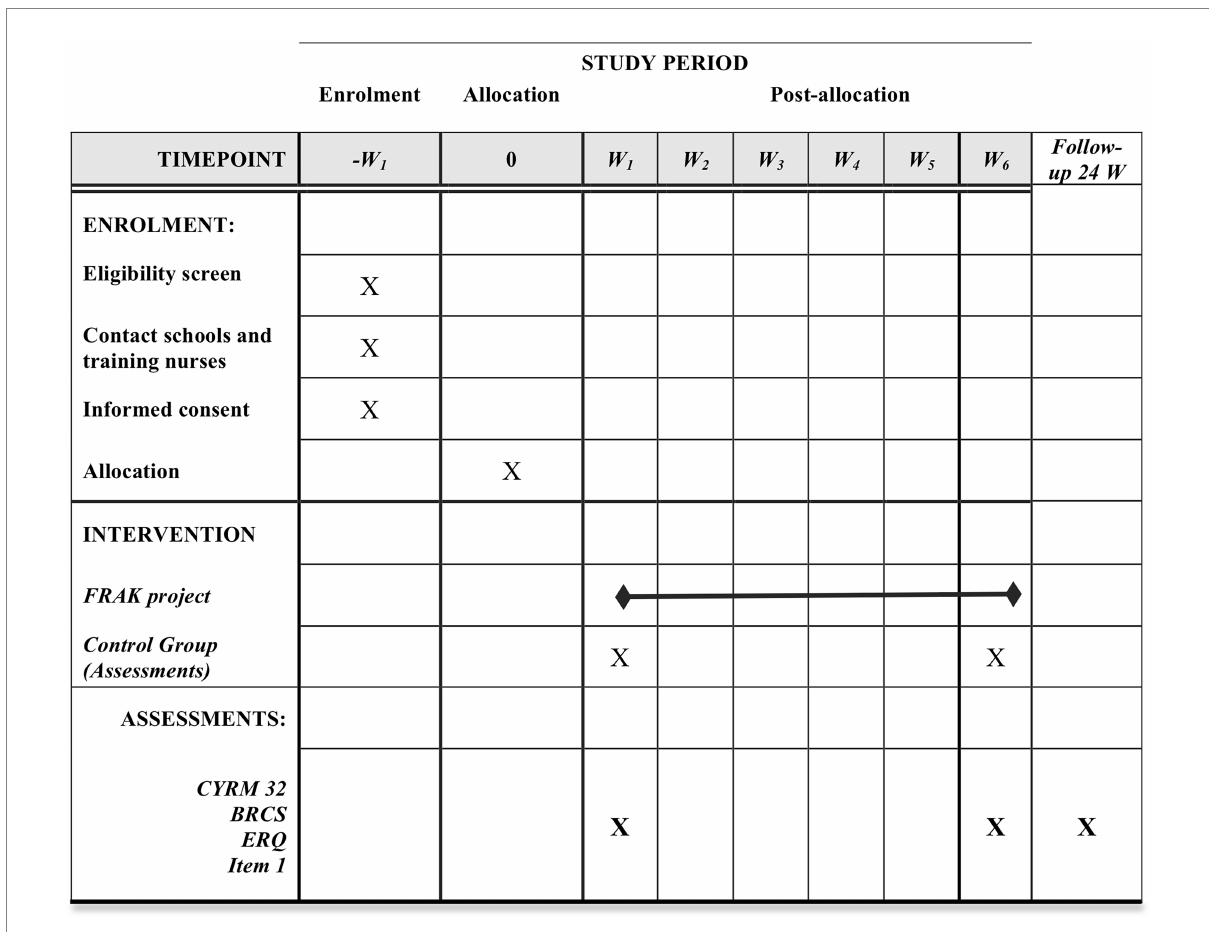
FIGURE 1 Fostering resilience in adolescents at risk study: Template enrolment, intervention and assessments. Adopting from figure SPIRIT. W, week; CYRM- 32, child youth resilience measure-32; BRCS, brief resilience scale; Item 1, “Are You Depressed or